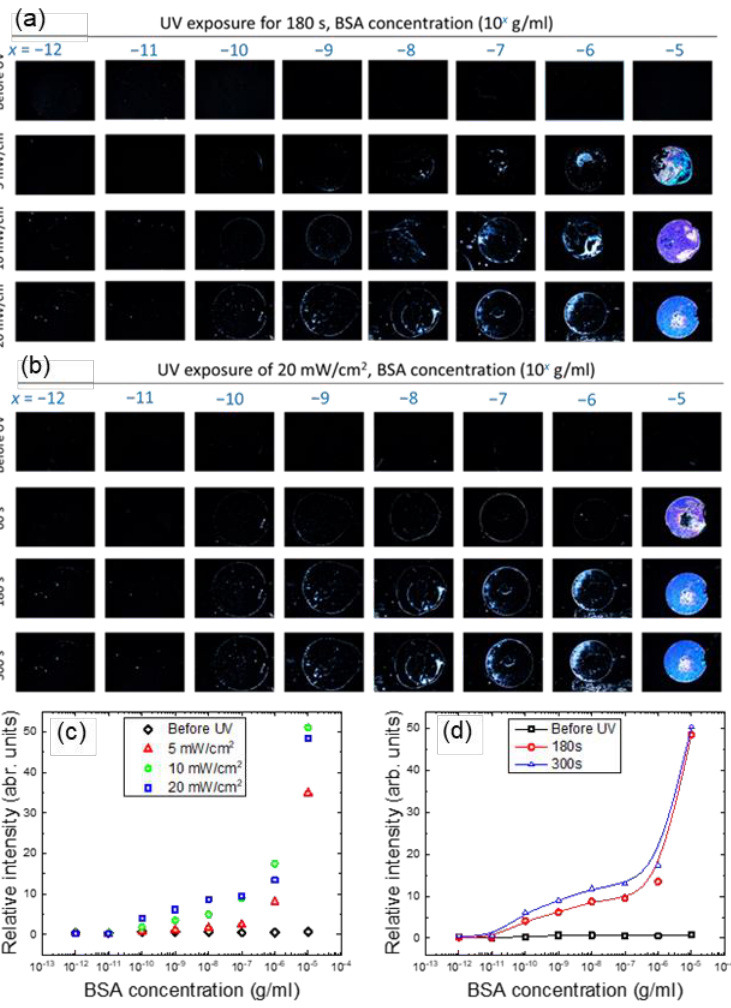
Figure 5. The optical texture of E7 doped with 4-wt.% NOA65 in the presence of BSA molecules. BSA was immobilized at concentrations ranging from 10 − 12 to 10 − 5 g/mL, followed by LC cell assembly and UV irradiation ( a ) at 5, 10, or 20 mW/cm 2 for 180 s, or ( b ) at 20 mW/cm 2 for 0, 60, 180, or 300 s. The brightness of the optical textures in Figure ( a , b ) was quantitated with ImageJ and plotted against the BSA concentration as depicted in Figure ( c , d ),